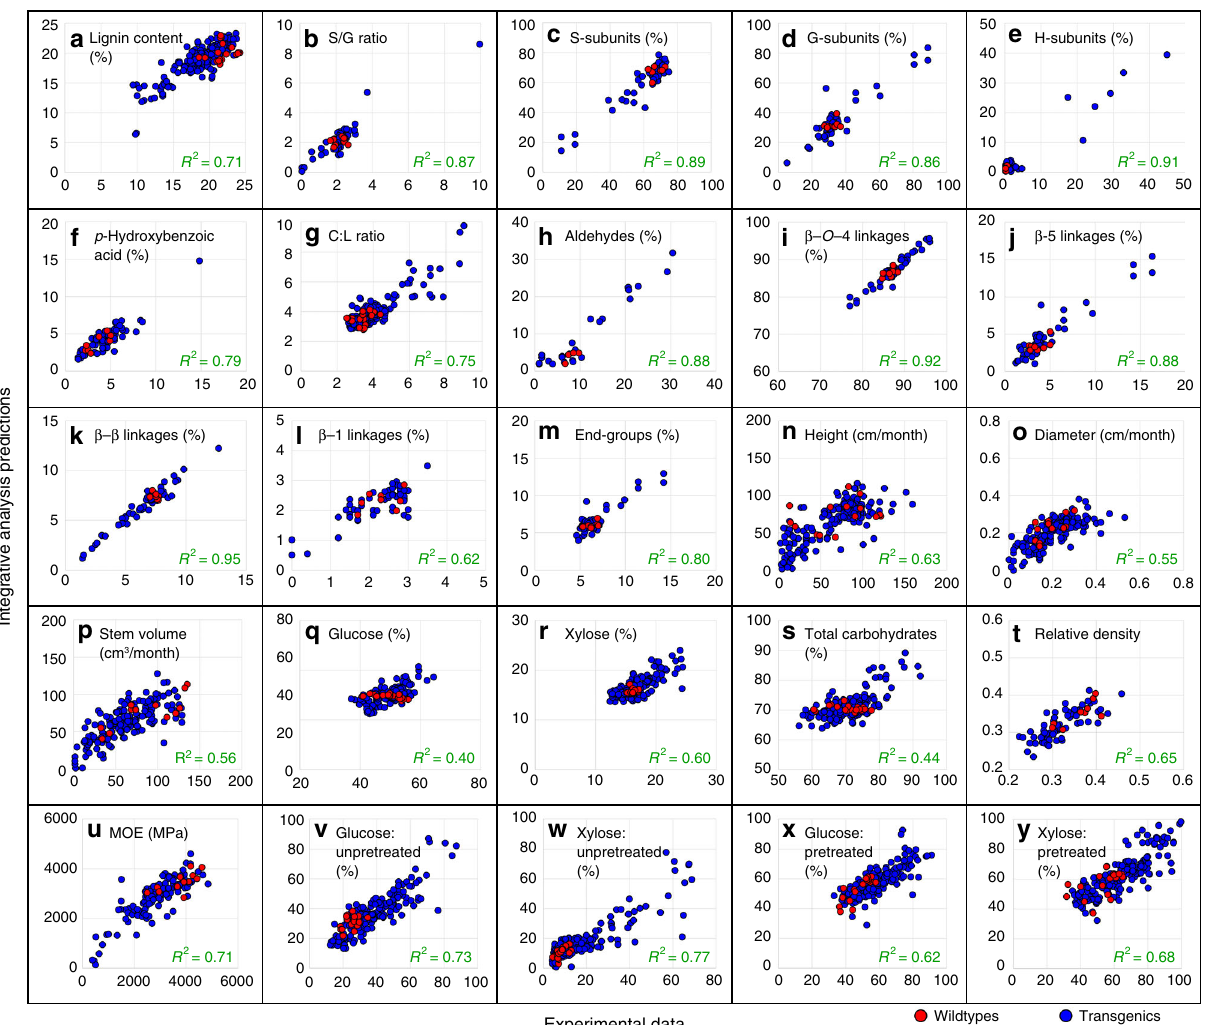
Fig. 9 Scatterplots of the phenotypic variations captured by the lignin-based integrative analysis. The monolignol transcript abundance was used as the only input for the multi-level integrative analysis to predict the corresponding protein abundance, predicted metabolic- fl ux, predicted metabolite concentrations, and the 25 lignin and wood properties. The fi gure shows that transcript abundance is used to predict the 25 lignin and wood properties ( y -axis, through the multi-level analysis), which are regressed on the experimental data ( x -axis, measured in transgenics and wildtype). a Lignin content; b S/G ratio; c S-subunits; d G-subunits; e H-subunits; f p -Hydroxybenzoic acid; g Carbohydrate to lignin (C:L) ratio; h Aldehyde content; i β – O – 4 linkages; j β – 5 linkages; k β – β linkages; l β – 1 linkages; m Cinnamyl alcohol end-groups; n Height; o Diameter; p Stem volume; q Glucose content; r Xylose content; s Total carbohydrates; t Relative density; u MOE; v – y Sacchari fi cation ef fi ciency for glucose ( v , x ) and xylose ( w , y ) release from unpretreated ( v , w ) or pretreated ( x , y ) wood samples. The R 2 values are coef fi cients of determination, showing the percent variation in dependent variables explained by monolignol gene transcript abundance as the predictor. Each data point represents a replicate pool of one wildtype or transgenic line containing 3 – 5 clonally propagated